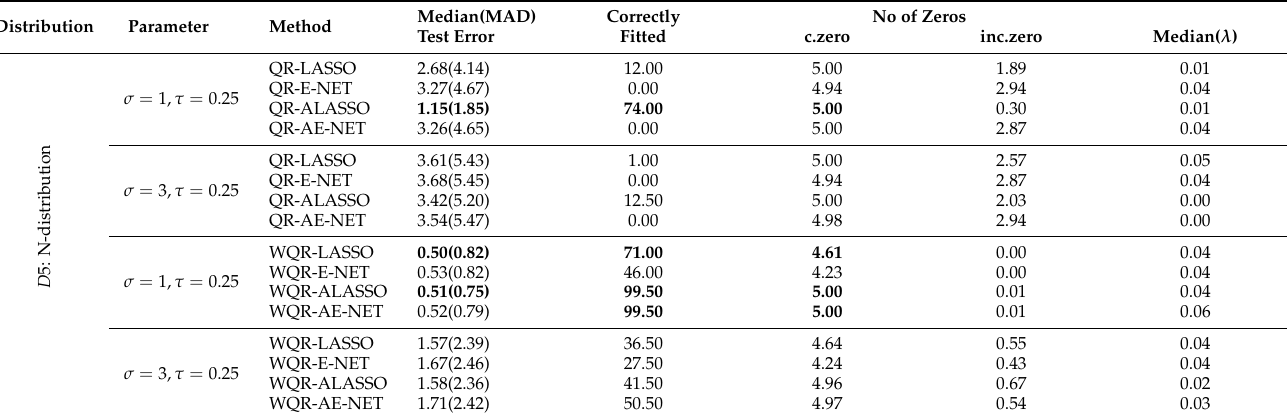
Table A2. Penalized weighted and unweighted quantile regression at D 5 for n = 50 ( τ = 0.25) under the normal